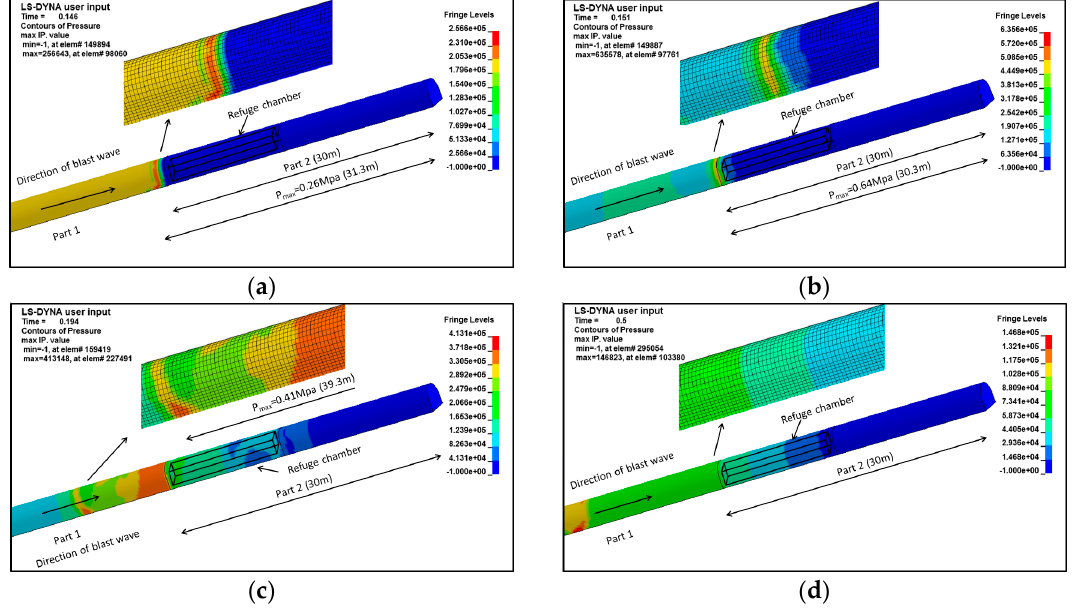
Figure 3. Pressure contour during the blast wave propagation in the tunnel. ( a ) t = 146 ms; ( b ) t = 151 ms; ( c ) t = 194 ms; (d) t = 500 ms.